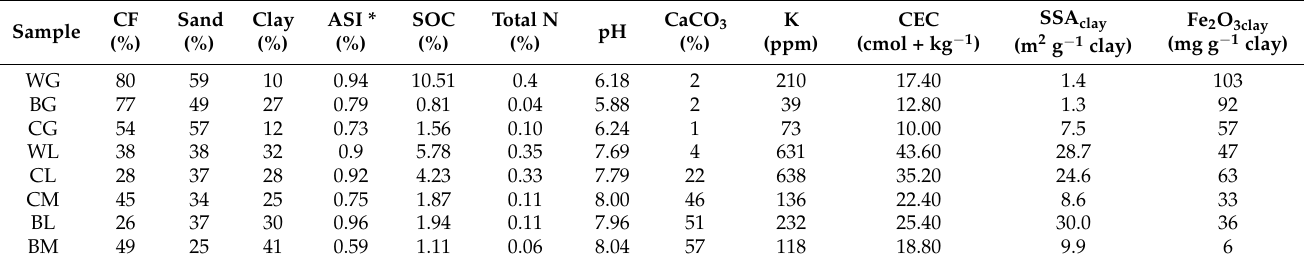
Table 2. Selected physical and chemical soil properties of the sites.